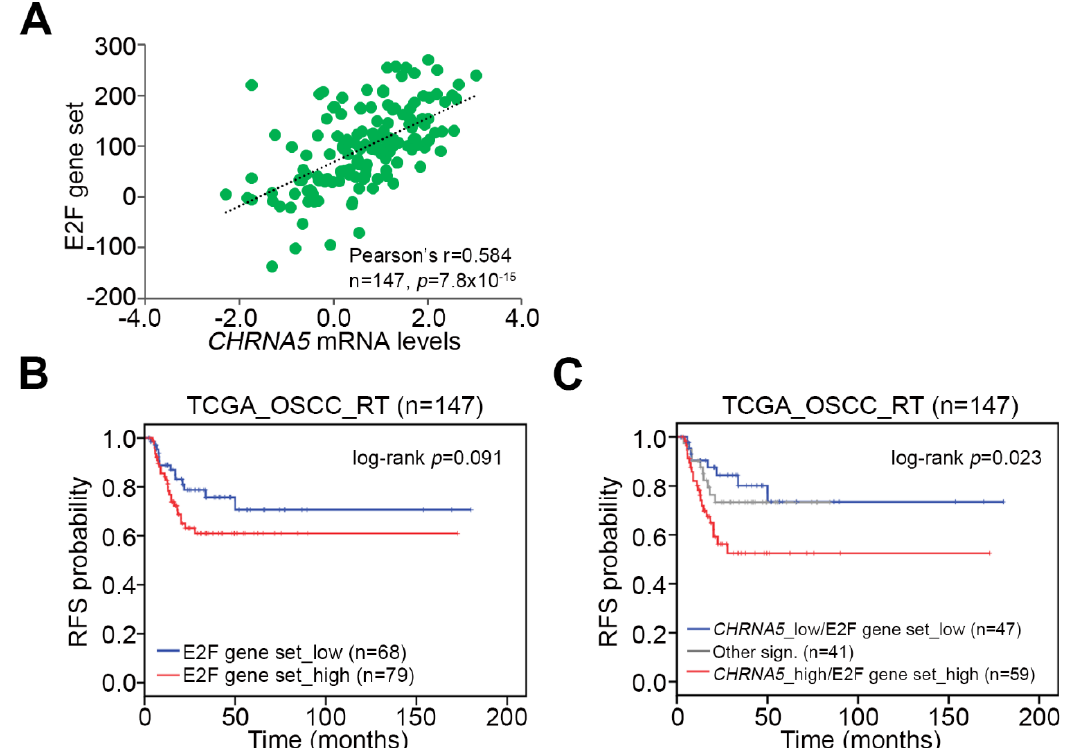
Figure 5. Prognostic significance of CHRNA5 transcript levels combined with the E2F gene signature in OSCC patients receiving radiotherapy. ( A ) Pearson correlation analysis for the sum of mRNA levels of E2F gene set and CHRNA5 mRNA levels in TCGA OSCC tissues. (B and C) Kaplan–Meier analyses for TCGA OSCC patients receiving radiotherapy, stratified by the transcript levels of the E2F gene set alone ( B ) or combined with the mRNA levels of CHRNA5 (C). In C, other signatures (sign.) indicate the combination of low-level CHRNA5 ( CHRNA5 _low) with low-level E2F gene set and of high-level CHRNA5 with high-level E2F gene